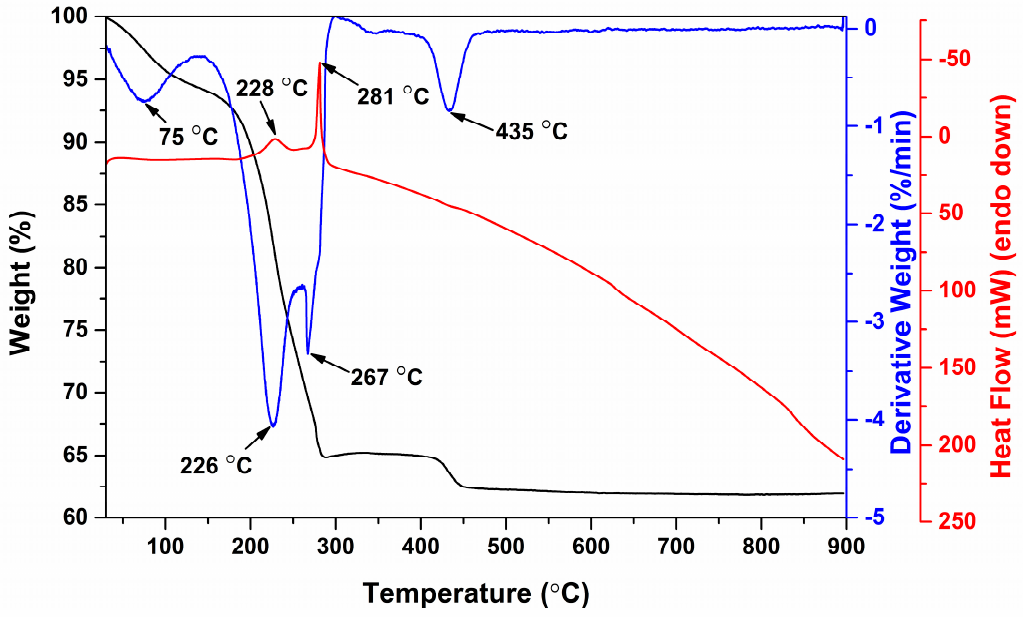
Figure 1. TG-DTG-DSC curves of BFO precursor gel.